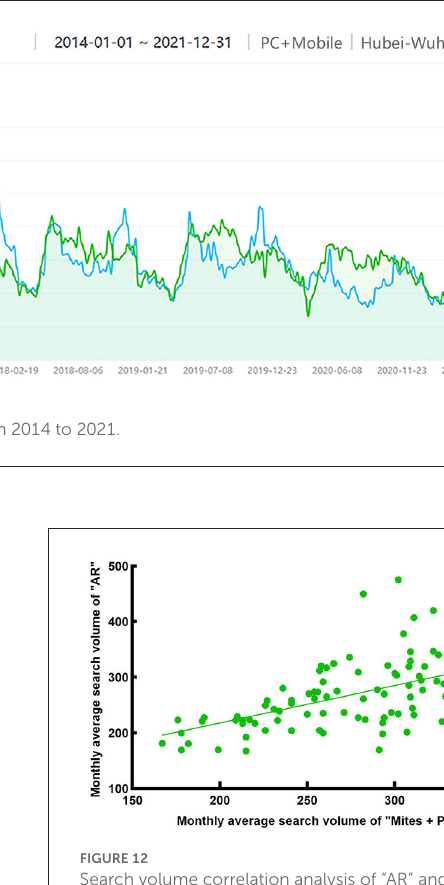
“Chronic rhinitis,” “Allergic rhinitis” in children” and “What to do when allergic rhinitis patients have eye itching” and so